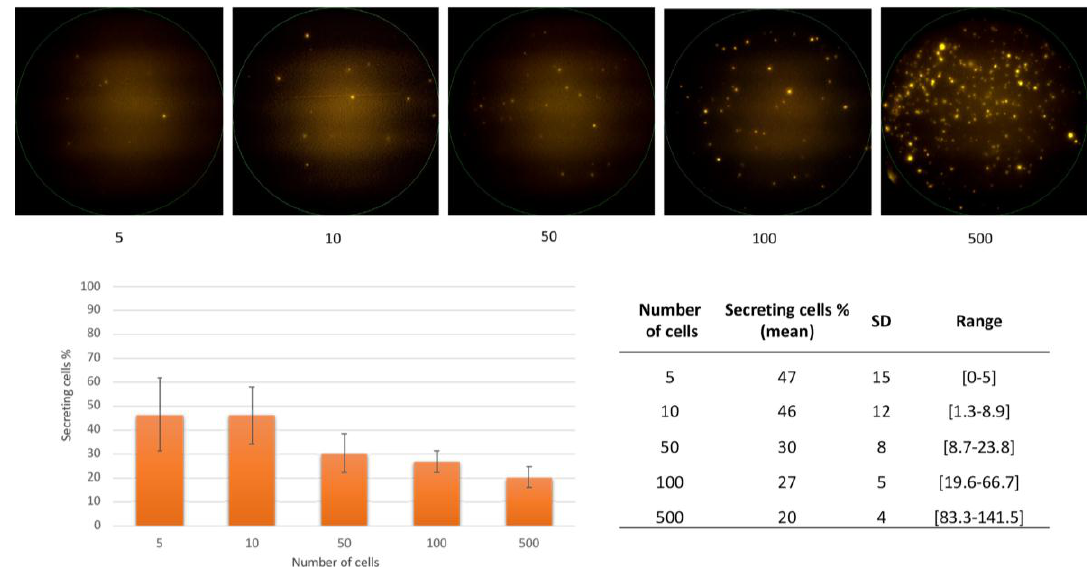
Figure 2. Melanoma cell detection using the S100-EPISPOT assay. Representative images of immunospots using WM-266-4 cells (upper panels) and percentage ( n = 3) of S100-secreting cells recovered from serial dilutions of WM-266-4 cells (lower panels). SD = standard deviation.